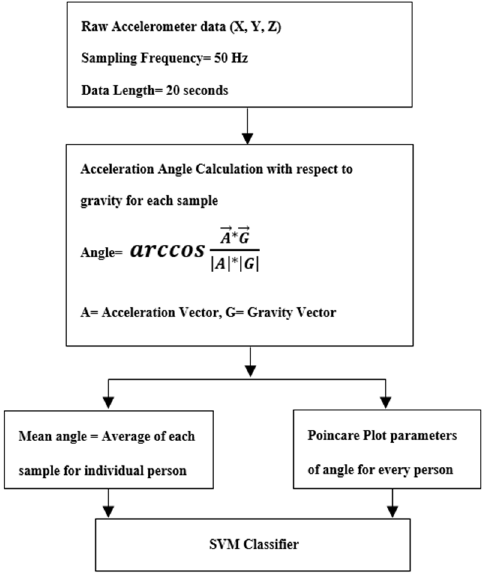
Figure 3. Feature extraction process. Figure 4. Actigraph count calculation process.